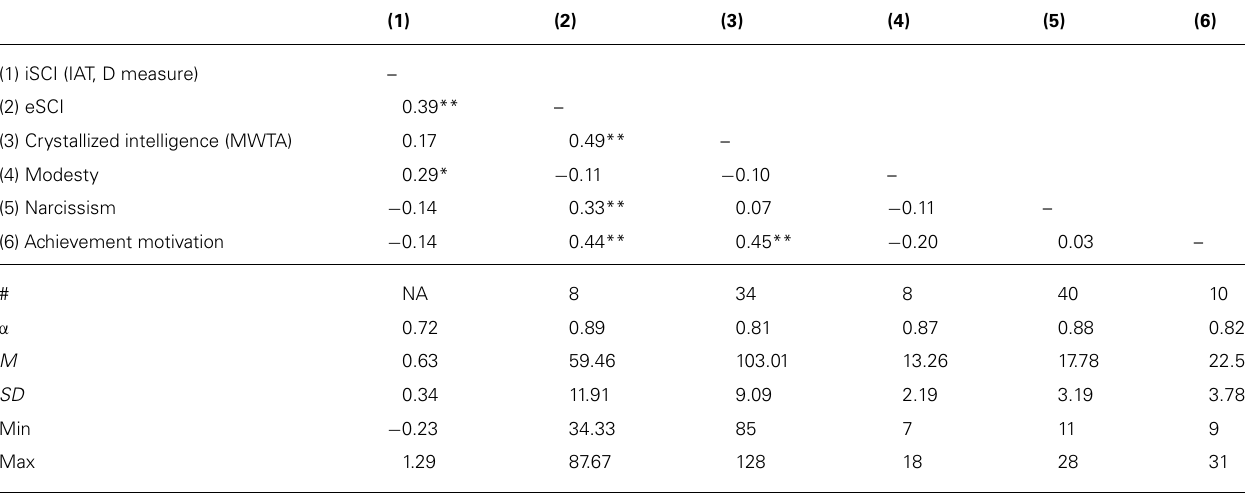
Table 1 | Descriptive statistics and correlations for all variables.